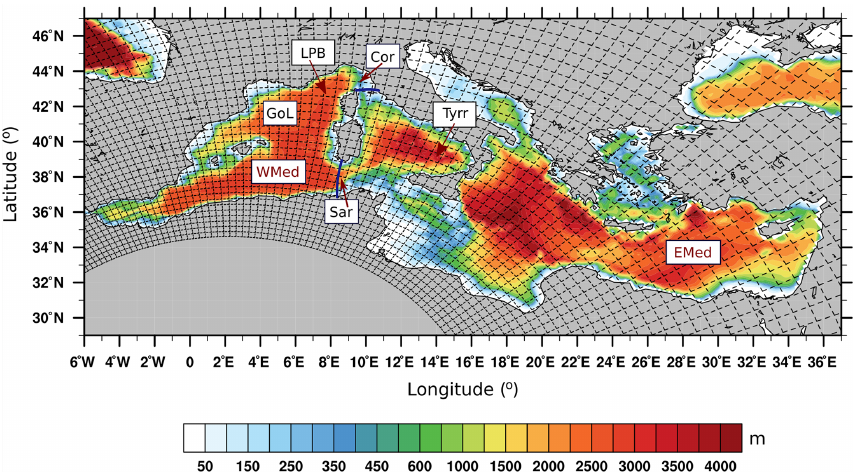
Figure 1. Bathymetry of the Mediterranean Sea adopted in ROM, in m, together with the oceanic grid (only one out of four lines are drawn). “WMed” and “EMed” refer to the western and eastern Mediterranean Sea, respectively. The arrows next to “Sar” and “Cor” indicate the location of the transects in which the transport across the Sardinia Strait and the Corsica Channel are measured (their coordinates are indicated in Figs. 4 and 5). “Tyrr” stands for Tyrrhenian, “GoL” for Gulf of Lions and “LPB” to Liguro-Provençal